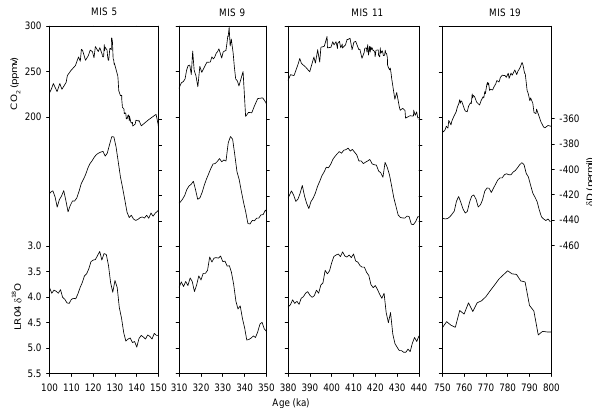
Fig. 8. Interglacial stages 5, 9, 11, and 19 showing variation in shape and trend between